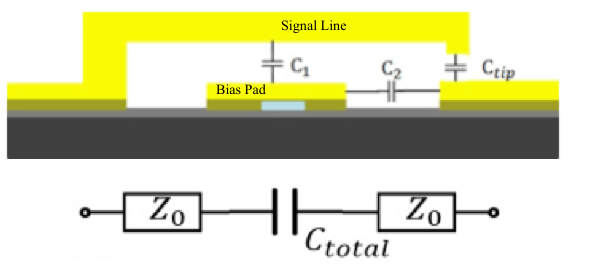
Figure 5. The parasitic capacitance of MEMS switch under OFF state and the switch’s equivalent circuit model.